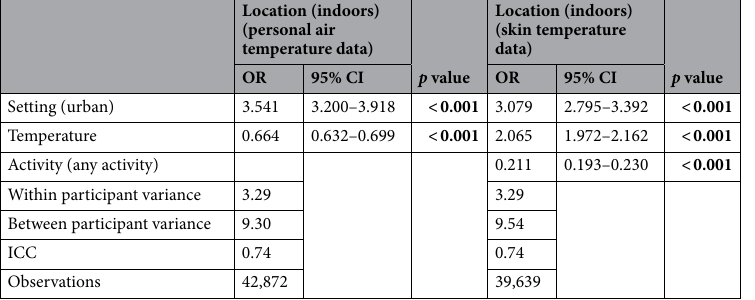
Table 4. Mixed effect models of participant location (indoors vs outdoors) as a function of the setting, temperature and activity groups using either the personal air or skin crude temperature sensor data. Statistically significant associations ( p -value < 0.05) are shown in bold.